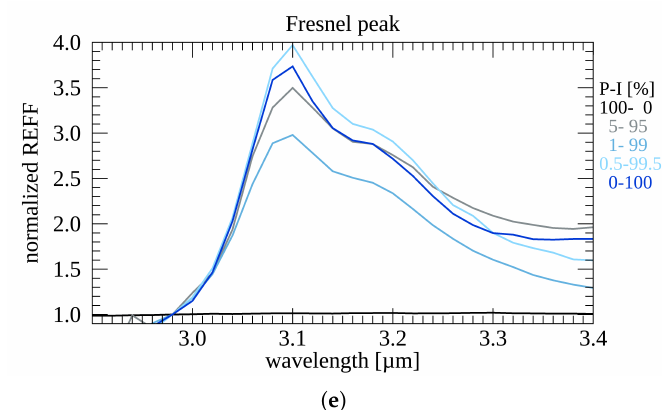
Figure 9. Water-ice-related absorption features ( a – d ) and Fresnel peak ( e ) for water ice–pyrrhotite < 25 intraparticle mixtures. Absorption bands are plotted after continuum-removal (the black dashed line in each plot indicates the continuum- removed baseline) while the Fresnel peak region is shown after normalization at 2.98 µ m. Pyrrhotite (K) and water ice (I) mass fractions are